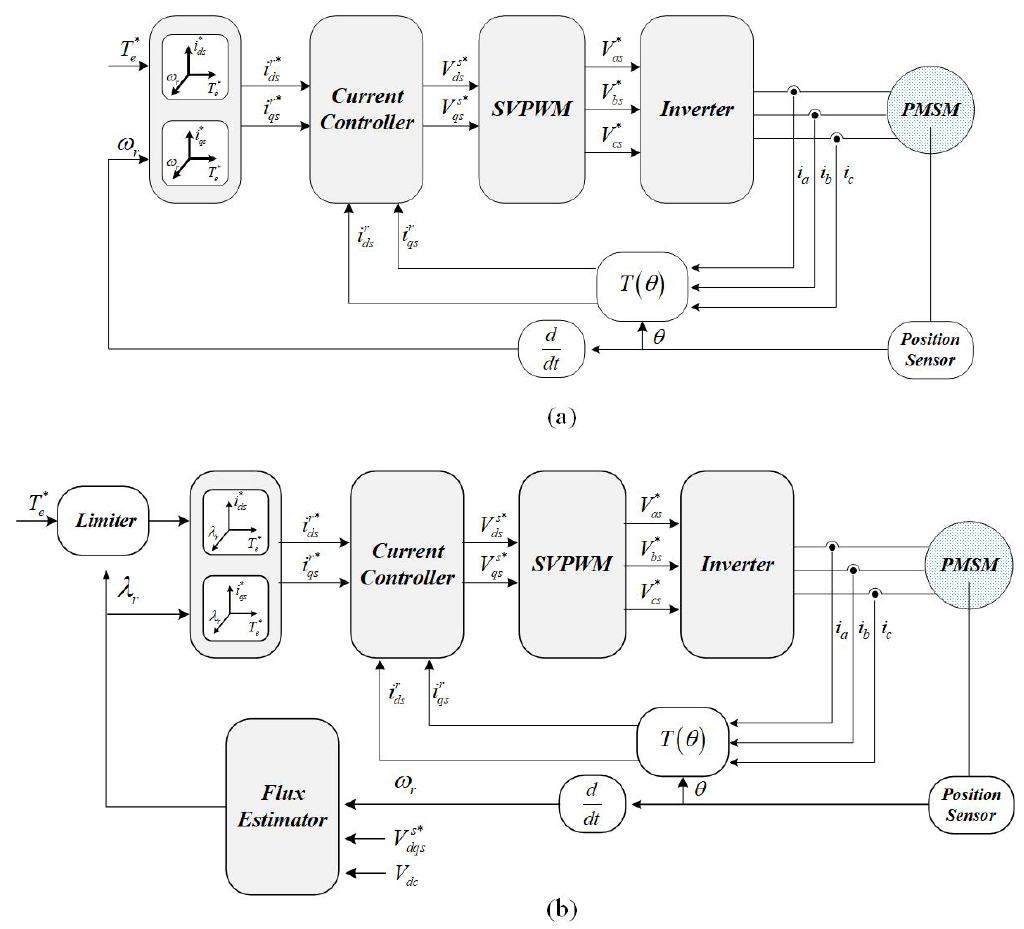
Figure 1. Conventional torque control methods based on 2D-LUT: ( a ) speed-torque table-based control and ( b ) flux-torque table-based